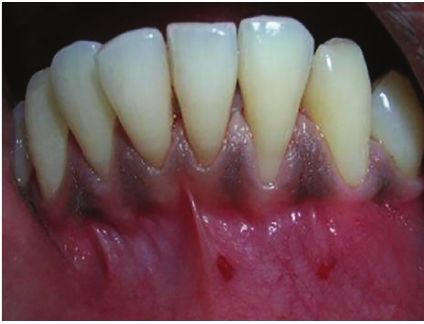
Figure 3: Proposed flap design for double papillary in relation to tooth number 32.